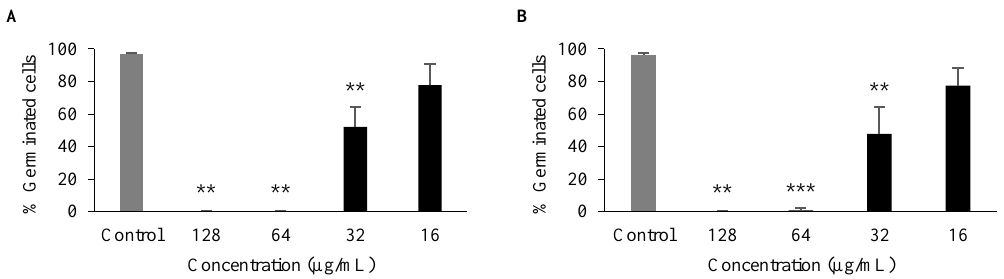
Figure 4. Percentage of C. albicans ATCC 10,231 germ tube formation after 3-h incubation with 3 ( A ), 26 ( B ). Data are shown as mean ± SD of at least three independent assays. One-sample t-test: ** p < 0.01, *** p < 0.001 significantly different from untreated control.